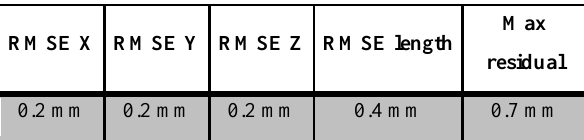
Table 2. Statistics resulting from the alignment through independent models adjustment. Note the improvements with respect to the results shown in Table